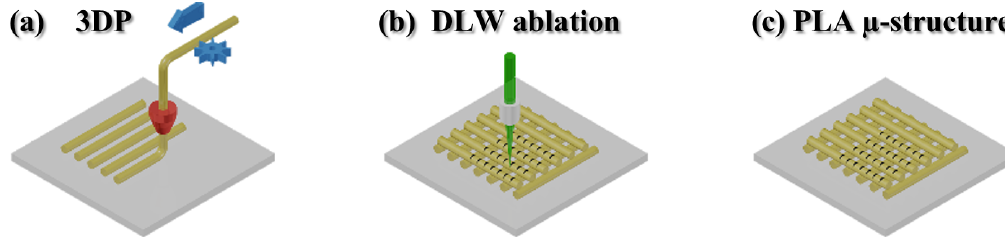
Figure 2. The schematic principle of fabrication by combining fused filament fabrication (FFF) and DLW techniques: ( a ) the 3D structure is printed by melting and extruding a material through a nozzle; ( b ) secondary structuring is realized employing DLW; ( c ) the final PLA (polylactic acid)